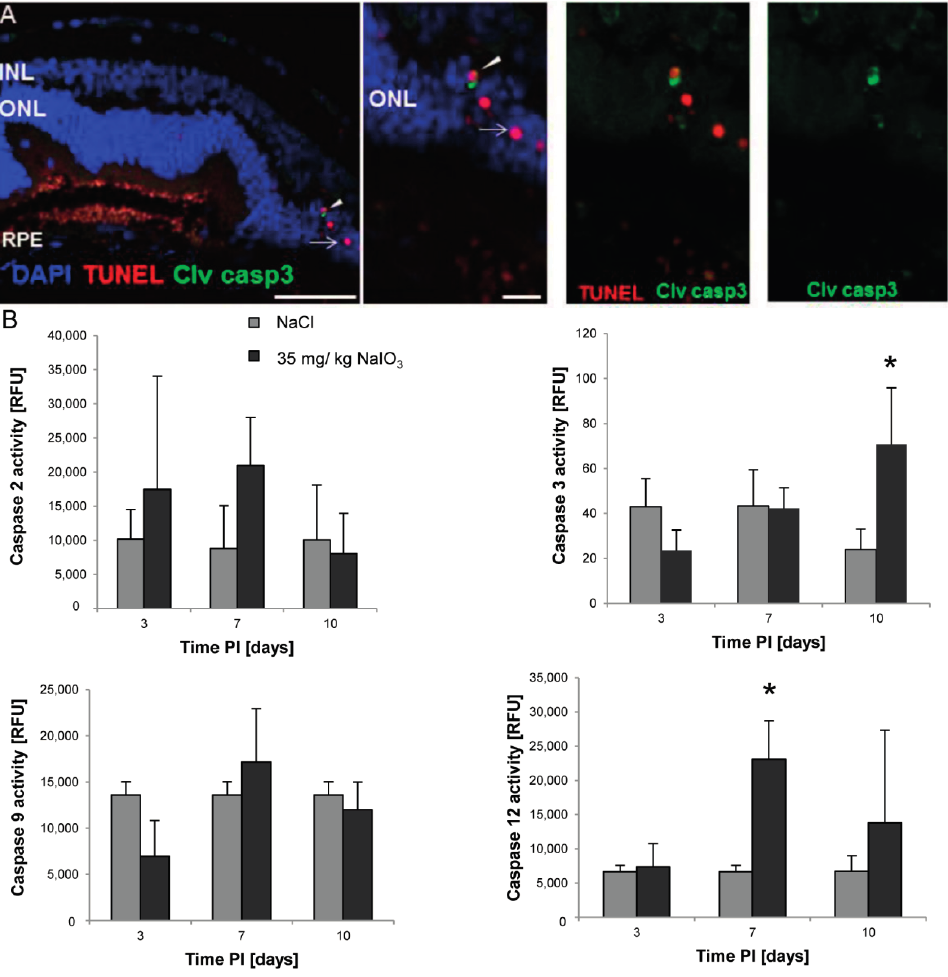
Figure 3. Caspase-dependent cell-death mechanisms are involved in PRC death in response to NaIO 3 . ( A ) Few cleaved caspase-3-positive cells (green) could be visualized in the ONL at day 3 post injection. A low number of cells shows co-localization with TUNEL positivity in red (arrowheads), whereas other caspase-3-positive cells were not TUNEL-positive (arrow), representing an early stage of cell death. Scale bar = 50 µm in the overview image, 10 μ m in the magnification images. GCL = Ganglion cell layer;INL = Inner nuclear layer; ONL = Outer nuclear layer; RPE = Retinal pigment epithelium; ( B ) In protein samples of retinas of NaIO 3 -treated mice, a significant upregulation ( * ) of caspase-3 (day 10) and caspase-12 (day 7) was detectable compared to the expression level in the untreated control